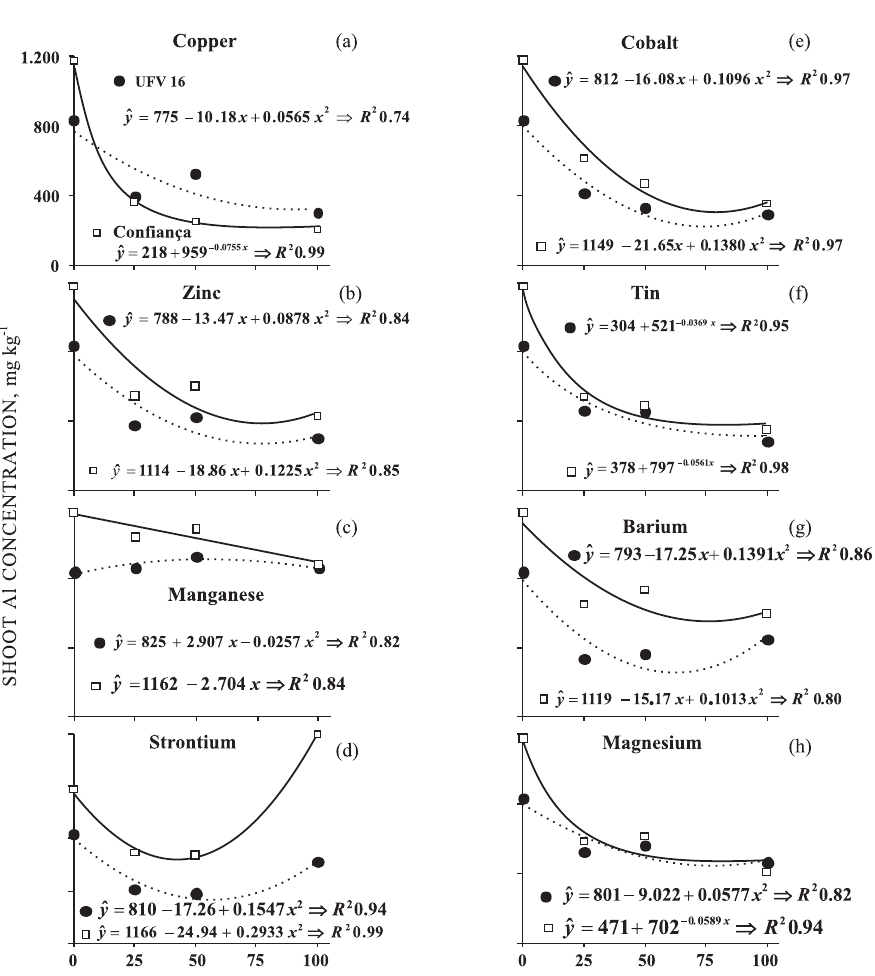
Figure 3. Aluminum concentration in roots of soybean cvs. UFV-16 and Confiança as a function of increasing 500 mmol L -1 (pH 4.5) basal solution, in the presence of 10 μ mol L -1 doses of divalent cations in a CaCl 2 Al. Error bars represent standard error (n =